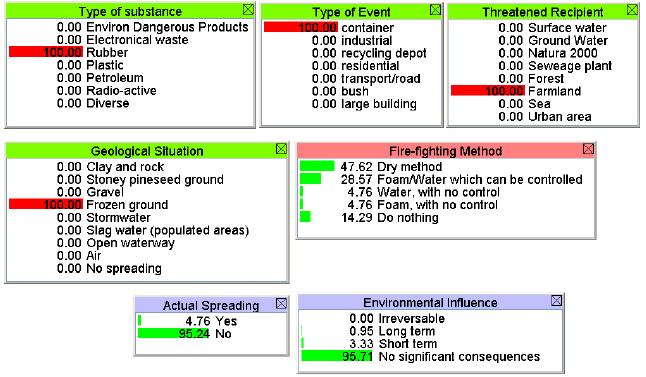
Figure 11: Prescriptive mode. What is the best fire-fighting method for a particular case?